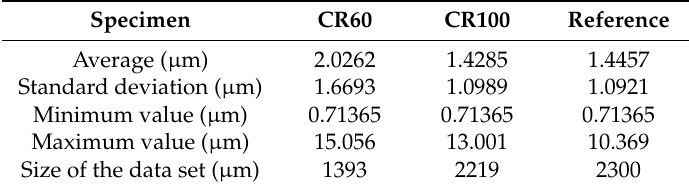
Table 5. The statistics of all boundaries with misorientations above 2 ◦ .